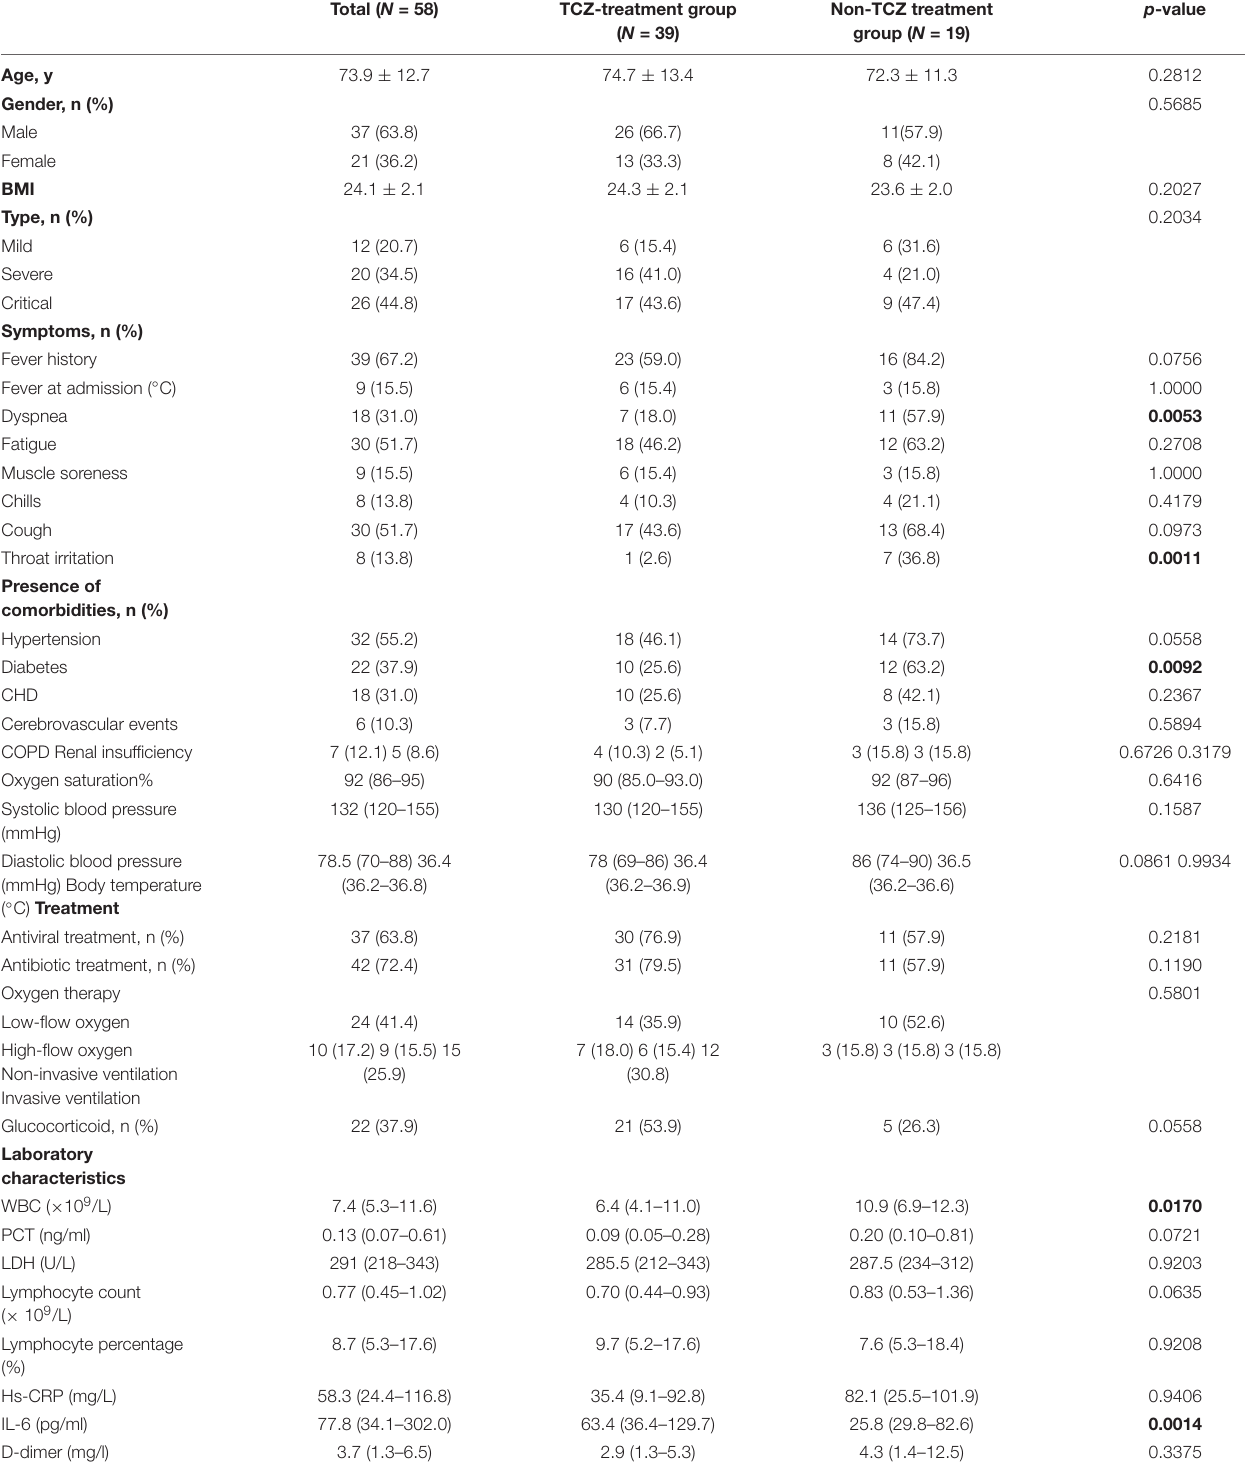
TABLE 1 | Clinical characteristics of the enrolled patients with coronavirus disease 2019 (COVID-19) treated with or without tocilizumab